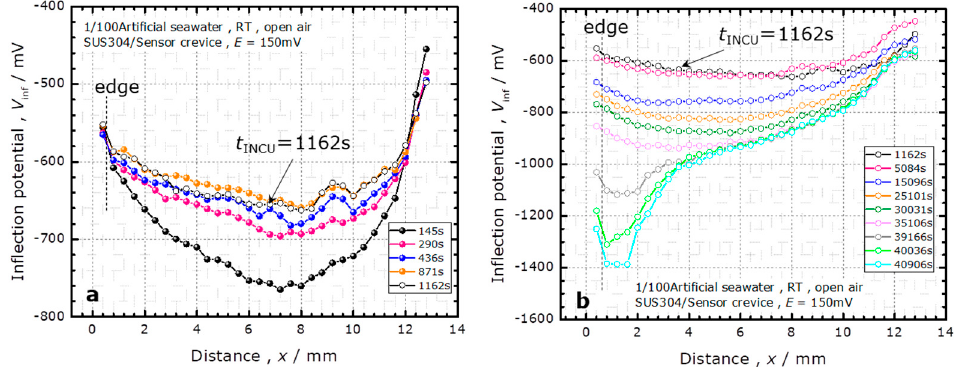
Figure 3. The temporal change of the spatial distribution of the inflection points of I–V curves ( V inf ) in the course of the potentiostatic test at E = 150 mV in 1 / 100 ASW. ( a ) The early stage before the occurrence of crevice corrosion; ( b ) The later stage after the occurrence of crevice corrosion.